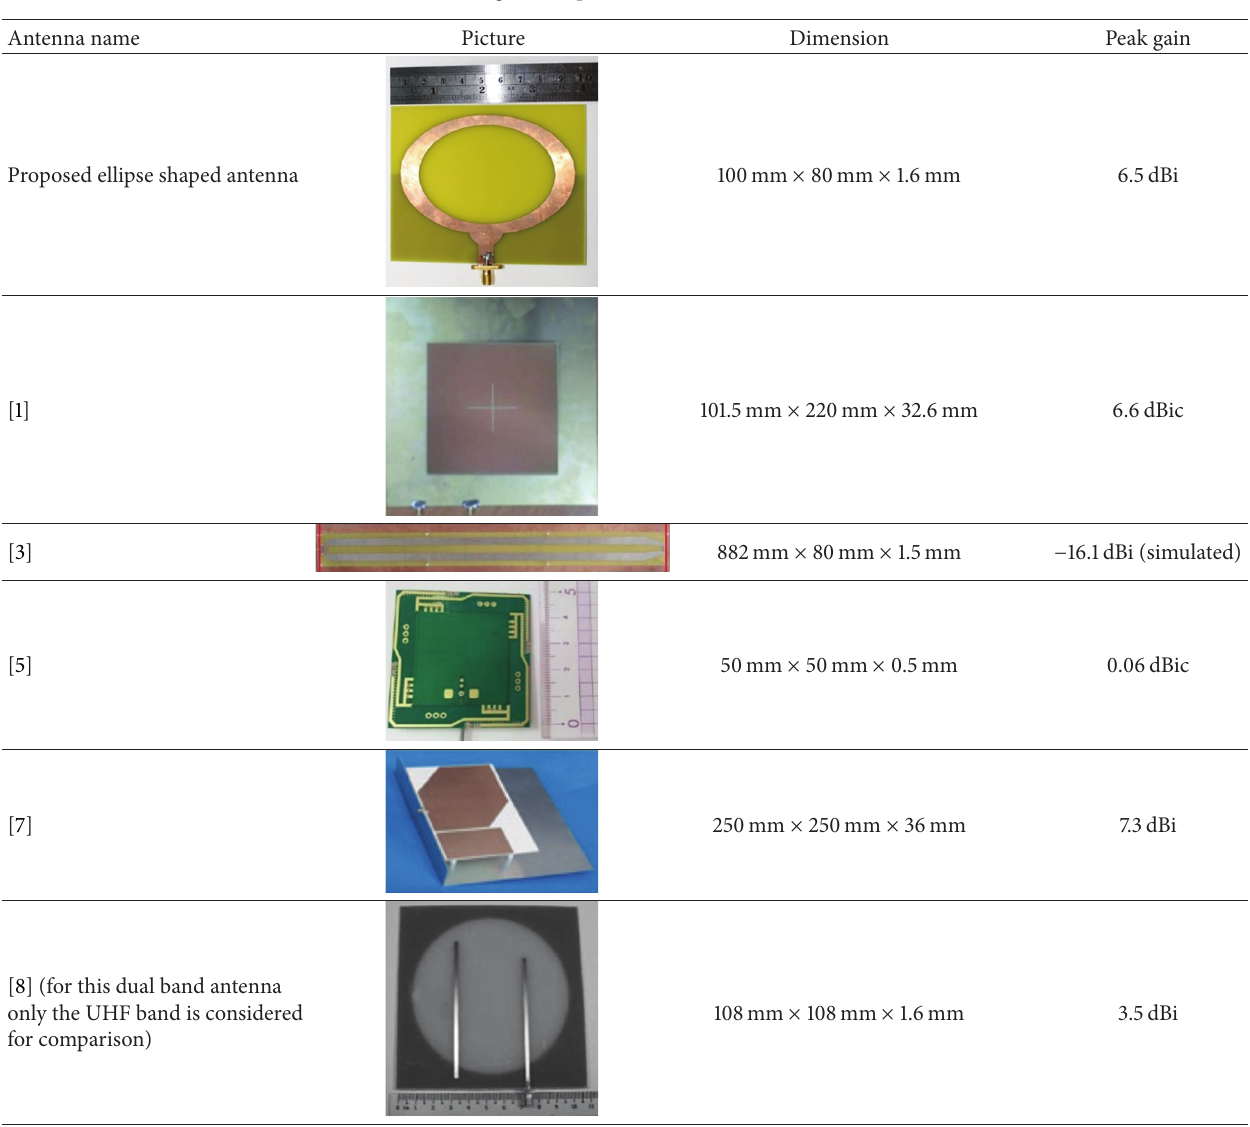
Table 2: Dimension and gain comparison between UHF RFID reader